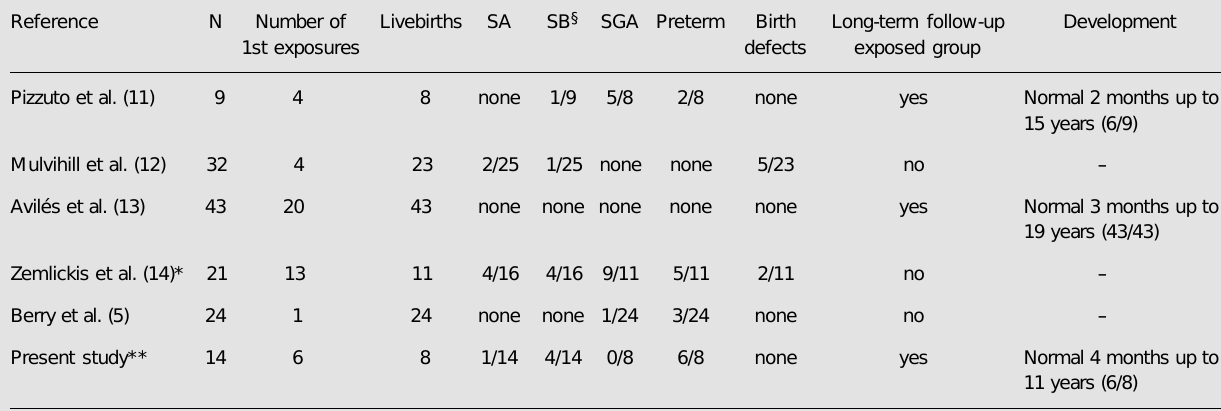
Table 7. Pregnancy outcomes in cancer patients: cohort studies and the present study.